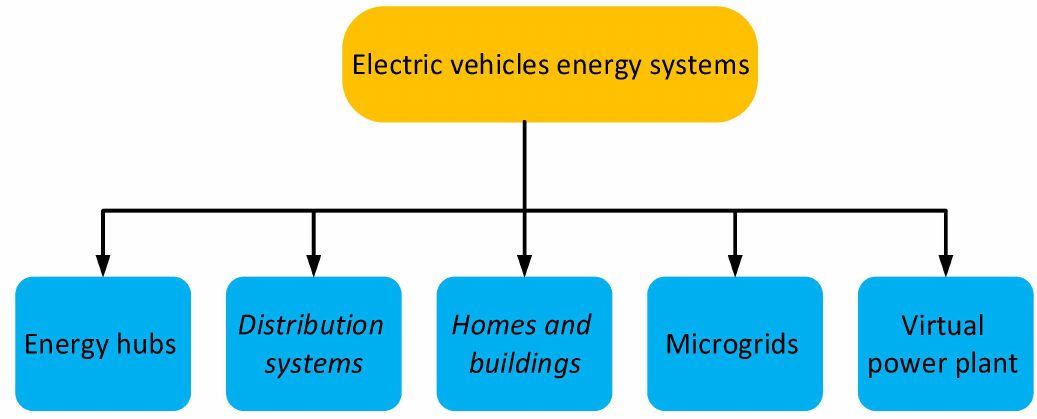
Figure 10. EV penetrated energy